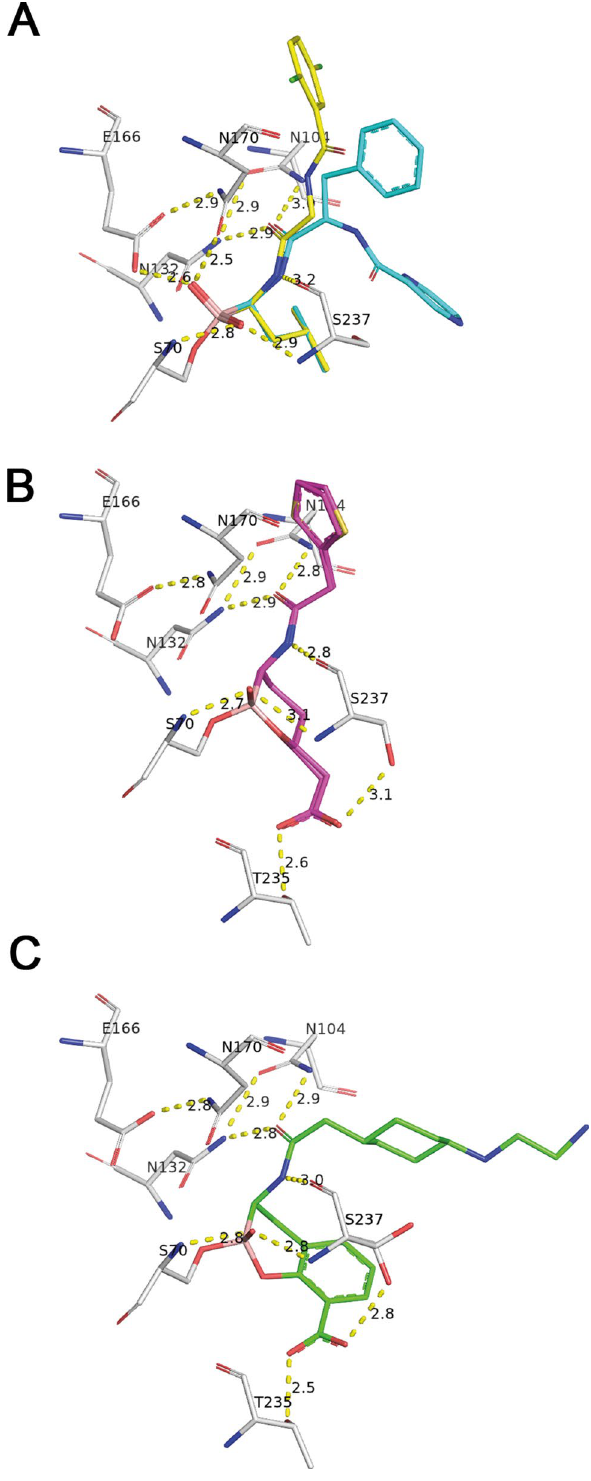
Figure 7. Comparison of the conserved hydrogen bonding network of bound inhibitors and active site residues. Bortezomib and Ixazomib are shown as stick model colored in cyan and yellow, respectively ( A ). The specific α-acylamino-boronate based β-lactamase inhibitor Vaborbactam is colored in pink ( B ) and Taniborbactam in green ( C